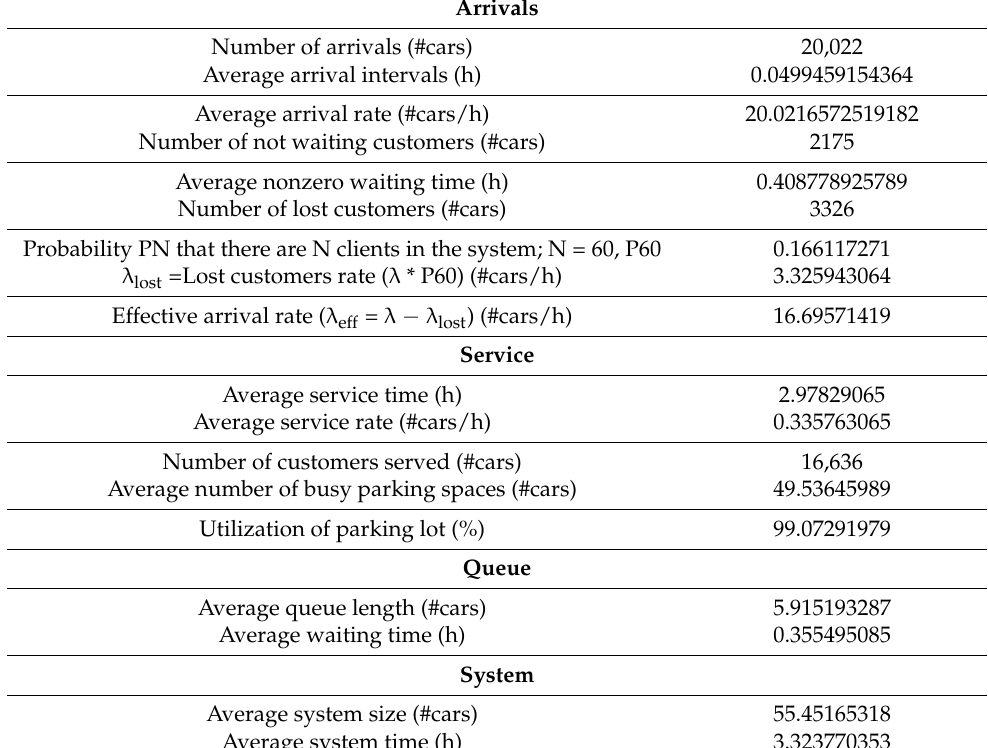
Table 9. Results of the 1000-h simulation of a parking lot model that includes an M/M/c/N queue system.